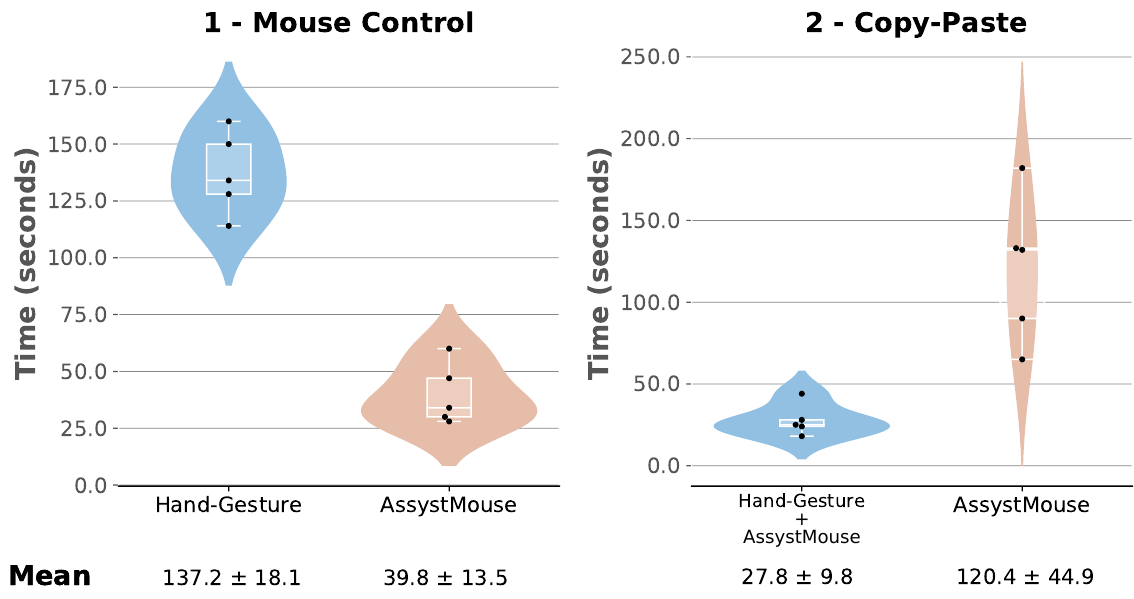
Figure 12. Distributions of the total completion times by task and